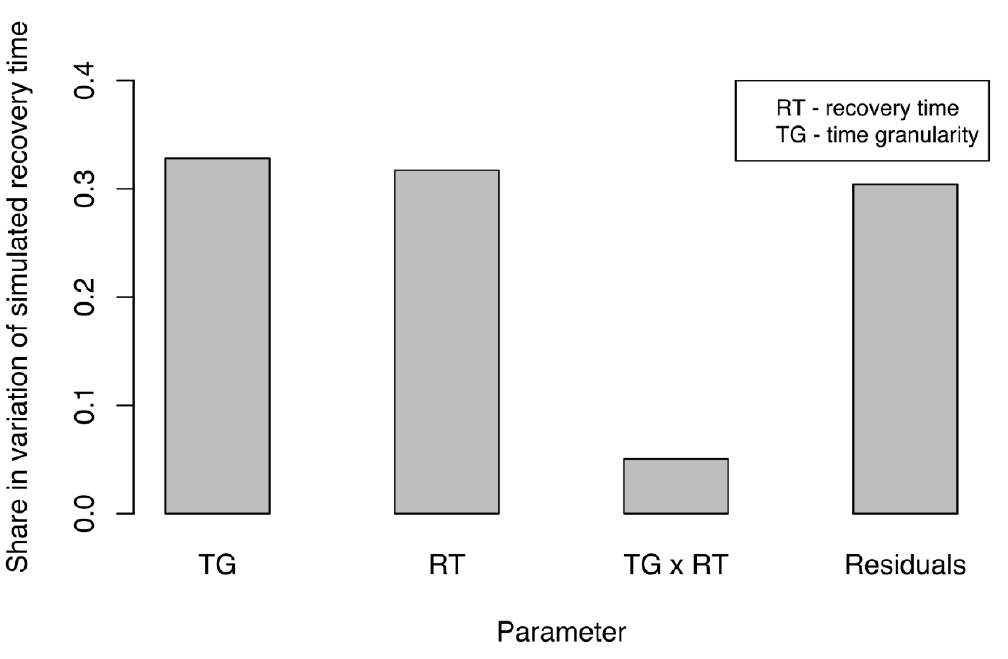
Figure 7. Variations in simulated recovery time (SPRT) due to experimental factors (parameters).